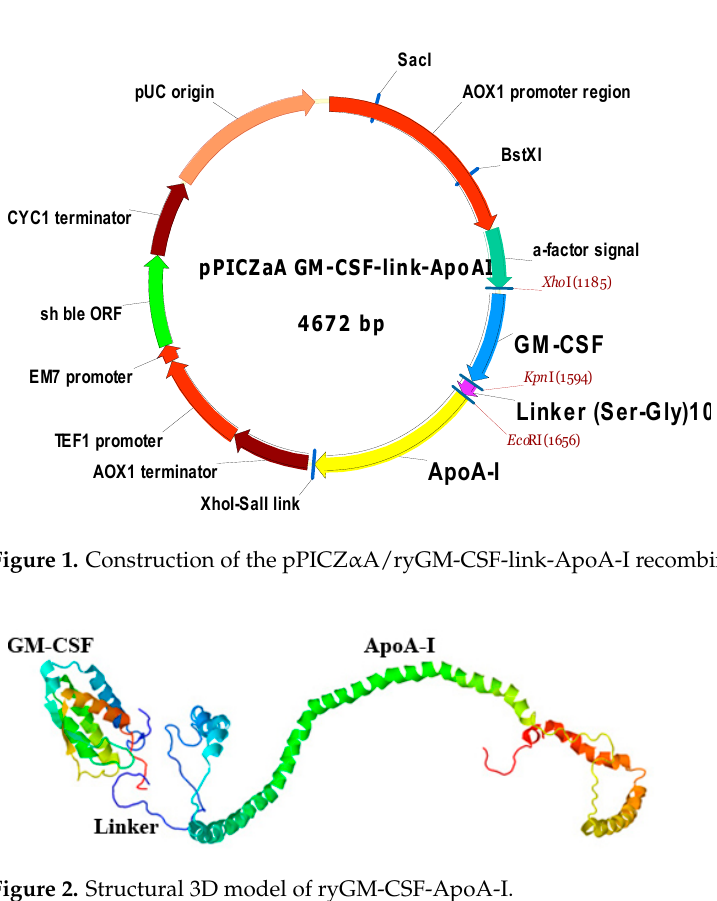
Figure 2. Structural 3D model of ryG М -CSF-ApoA-I.